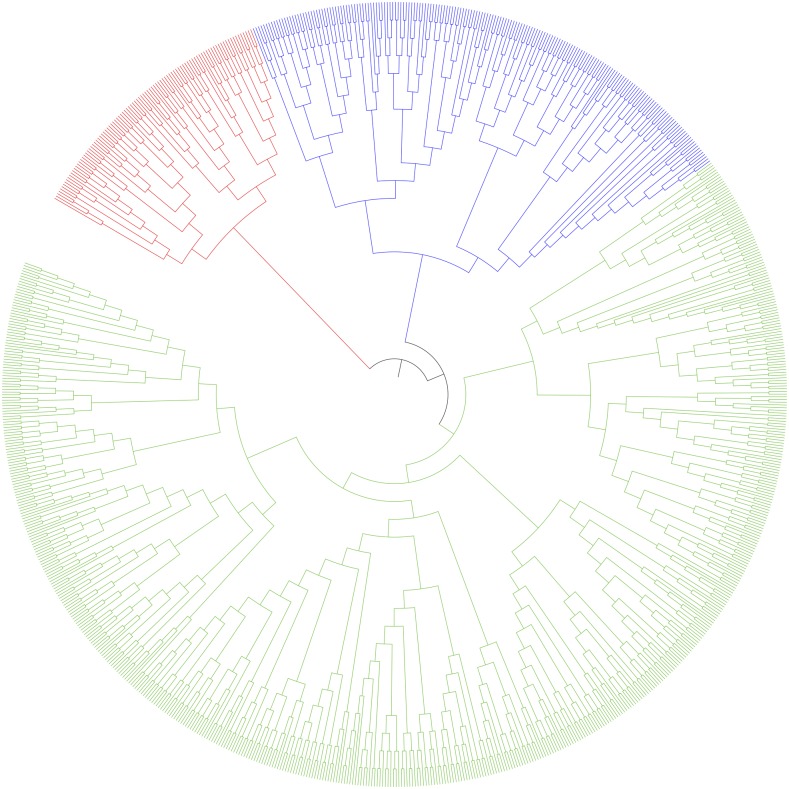
Global pattern of genetic differentiation. Distance tree based on a custom distance matrix measuring the number of shared alleles over the total number of alleles between two individuals. The tree was constructed using the Ward clustering algorithm. The distances are not represented to scale on the tree so as to make the dendrogram more readable. Red, wild/landrace; Blue, winter; Green, spring.